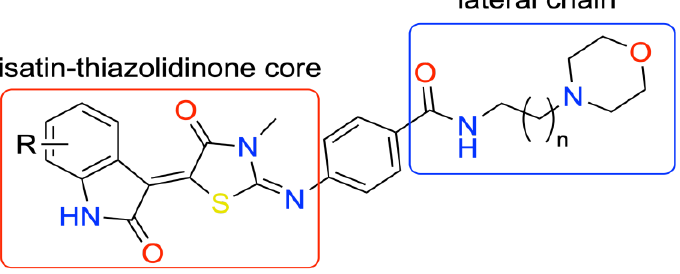
Figure 18. General structure of proposed dual-targeting hit compounds.